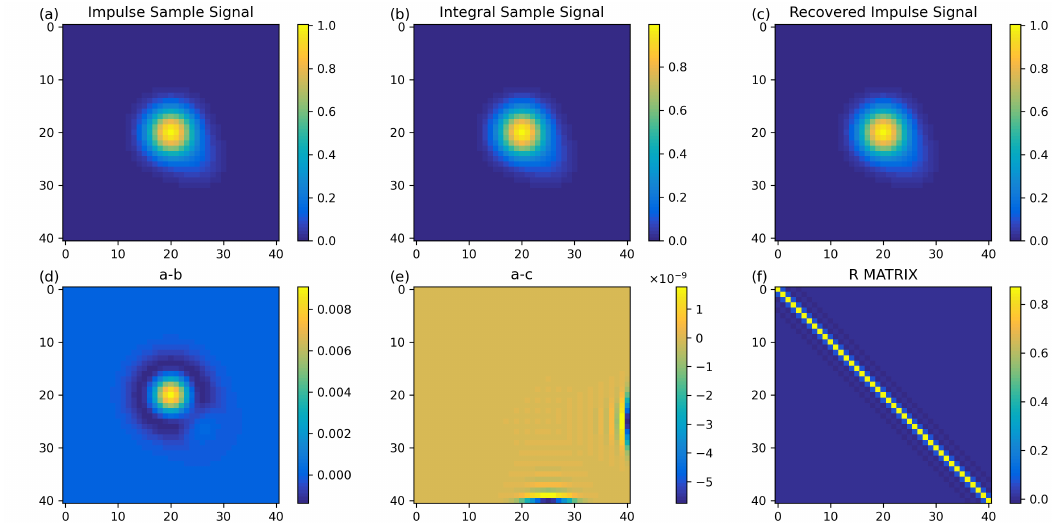
Figure 3. Simulations for two-point sources collected by an imaging system with a Gaussian PSF shown in the pixel coordinate. The point sources are at ( 21,21 ) and ( 26,26 ) in pixel coordinate on the object plane. ( a ) is the impulse sample signal. ( b ) is the integral sample signal. ( c ) shows the recovered impulse signal from ( b ). ( d ) is the error image of ( a , b ). ( e ) is the error image of ( a , d ). ( f ) is the R matrix for this